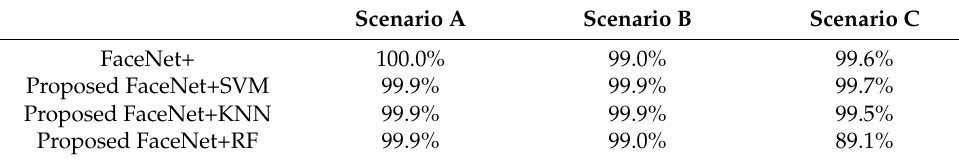
Table 9. Close-set face recognition accuracy on testing scenarios A, B, and